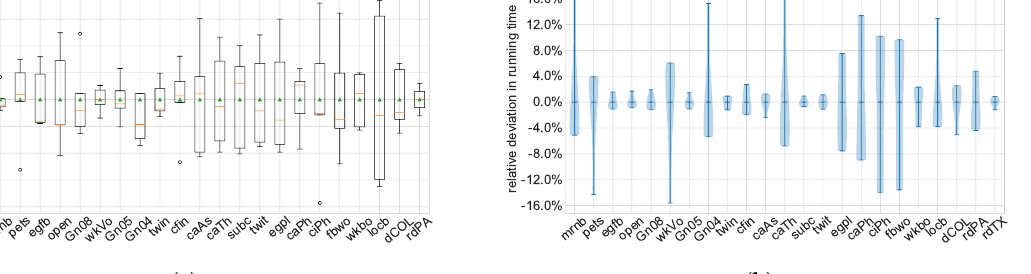
Figure 7. Plots on variance of running times. For each instance in the evaluation set, we perform 5 repeated runs and calculate the mean. Shown in the plot are, for each run, the distance to the mean, divided by the mean. This way we get the relative running time variance for every instance. Here, we use a box and a violin plot for illustration purposes; in a scientific paper one of the two should be chosen. Notice also that instances roadNet-PA (rdPA), roadNet-TX (rdTX) are missing for RK since it did not finish within the 7 h limit. ( a ) A box plot for running time deviation of RK . The orange line indicates the median. ( b ) A violin plot for running time deviation of KADABRA